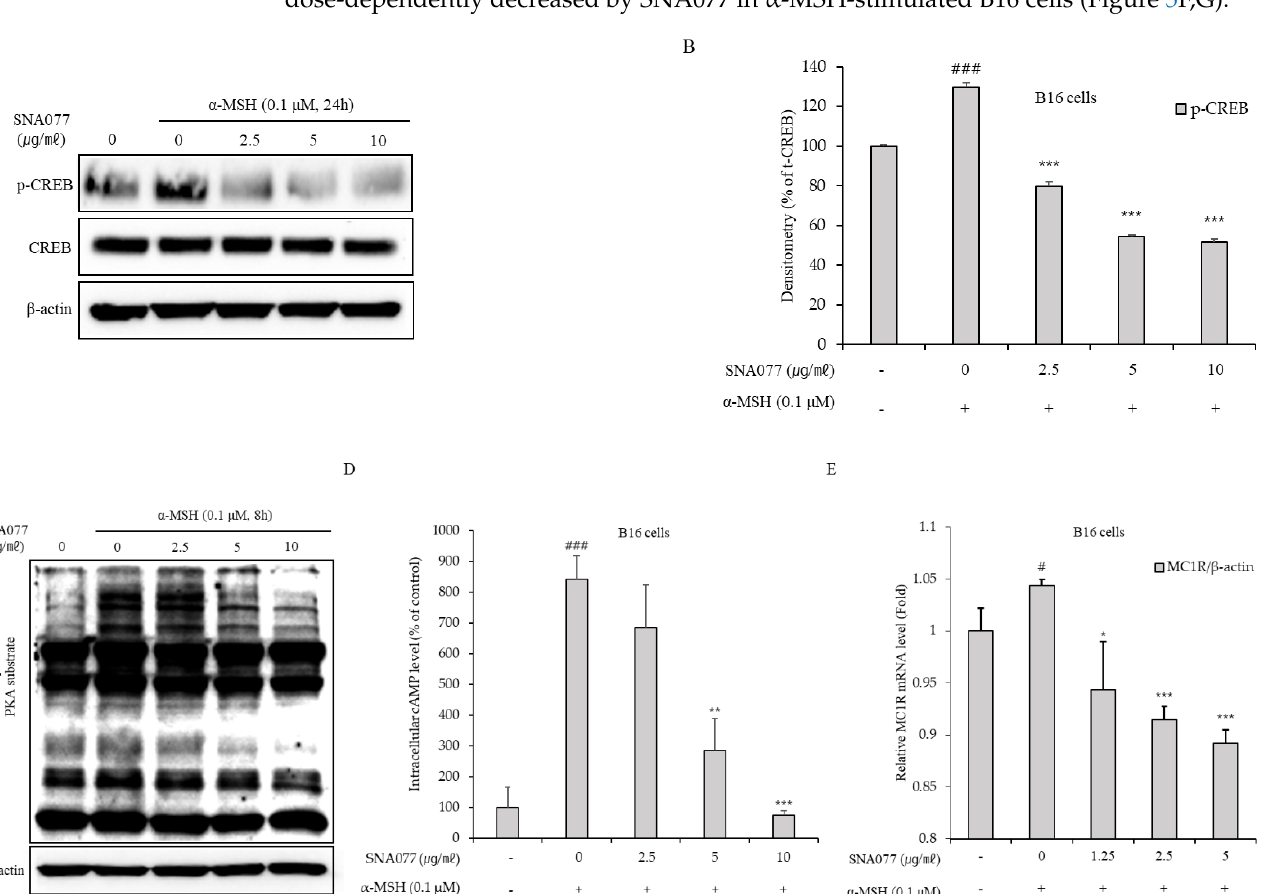
Figure 5. Inhibitory effect of SNA077 on α -MSH-induced cAMP/PKA/CREB and MAPK signaling in B16 cells . ( A , C ) Protein levels of phospho-CREB ( A ) and phospho-PKA substrate ( C ) were deter- mined by Western blot analysis in B16 cells. Cells were treated with SNA077 for the indicated times. Equal amounts of proteins from B16 cells were resolved by 10% SDS-PAGE and detected using